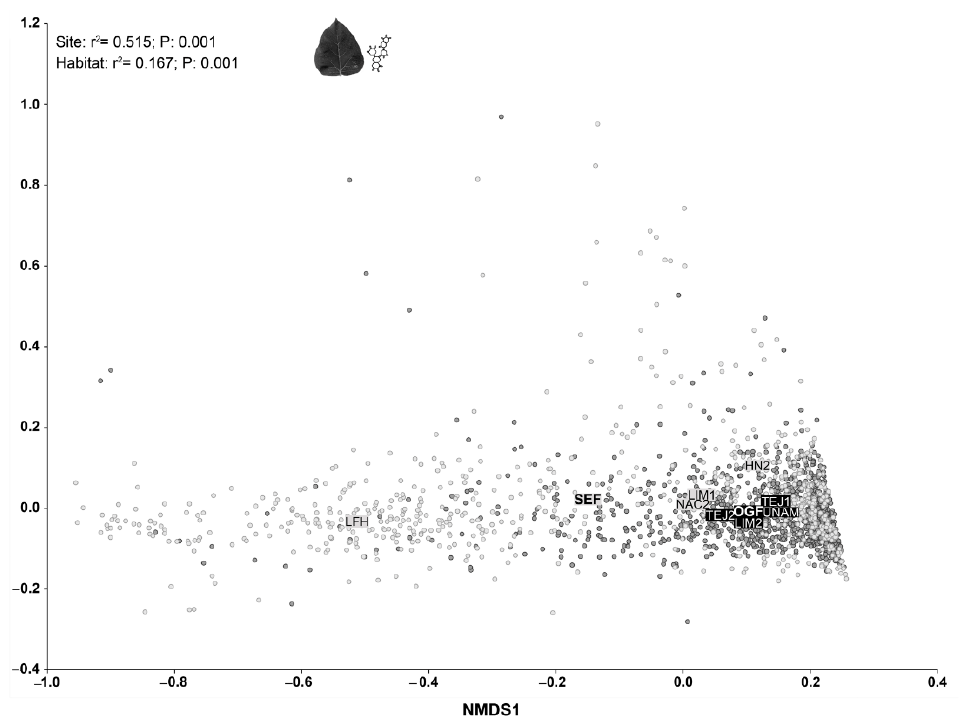
Figure 2. Non-Metric Multidimensional Scaling Ordinations mapping individuals’ dissimilarities in terms of their functional traits. Light gray points and labels correspond to secondary forests whereas black points and labels correspond to old-growth forests. The squares represent the centroids of the different types of habitats (secondary forest: SEF, and old-growth forest: OGF) and sampled communities (SEF: HN2, LFH, LIM1, NAC2; and OGF: LIM2, TEJ1, TEJ2, UNAM). The results of the centroids test are shown on the upper left side of the graphs. Table 1. Community weighed mean values (CWM) regarding the study functional traits for secondary and old-growth forests.